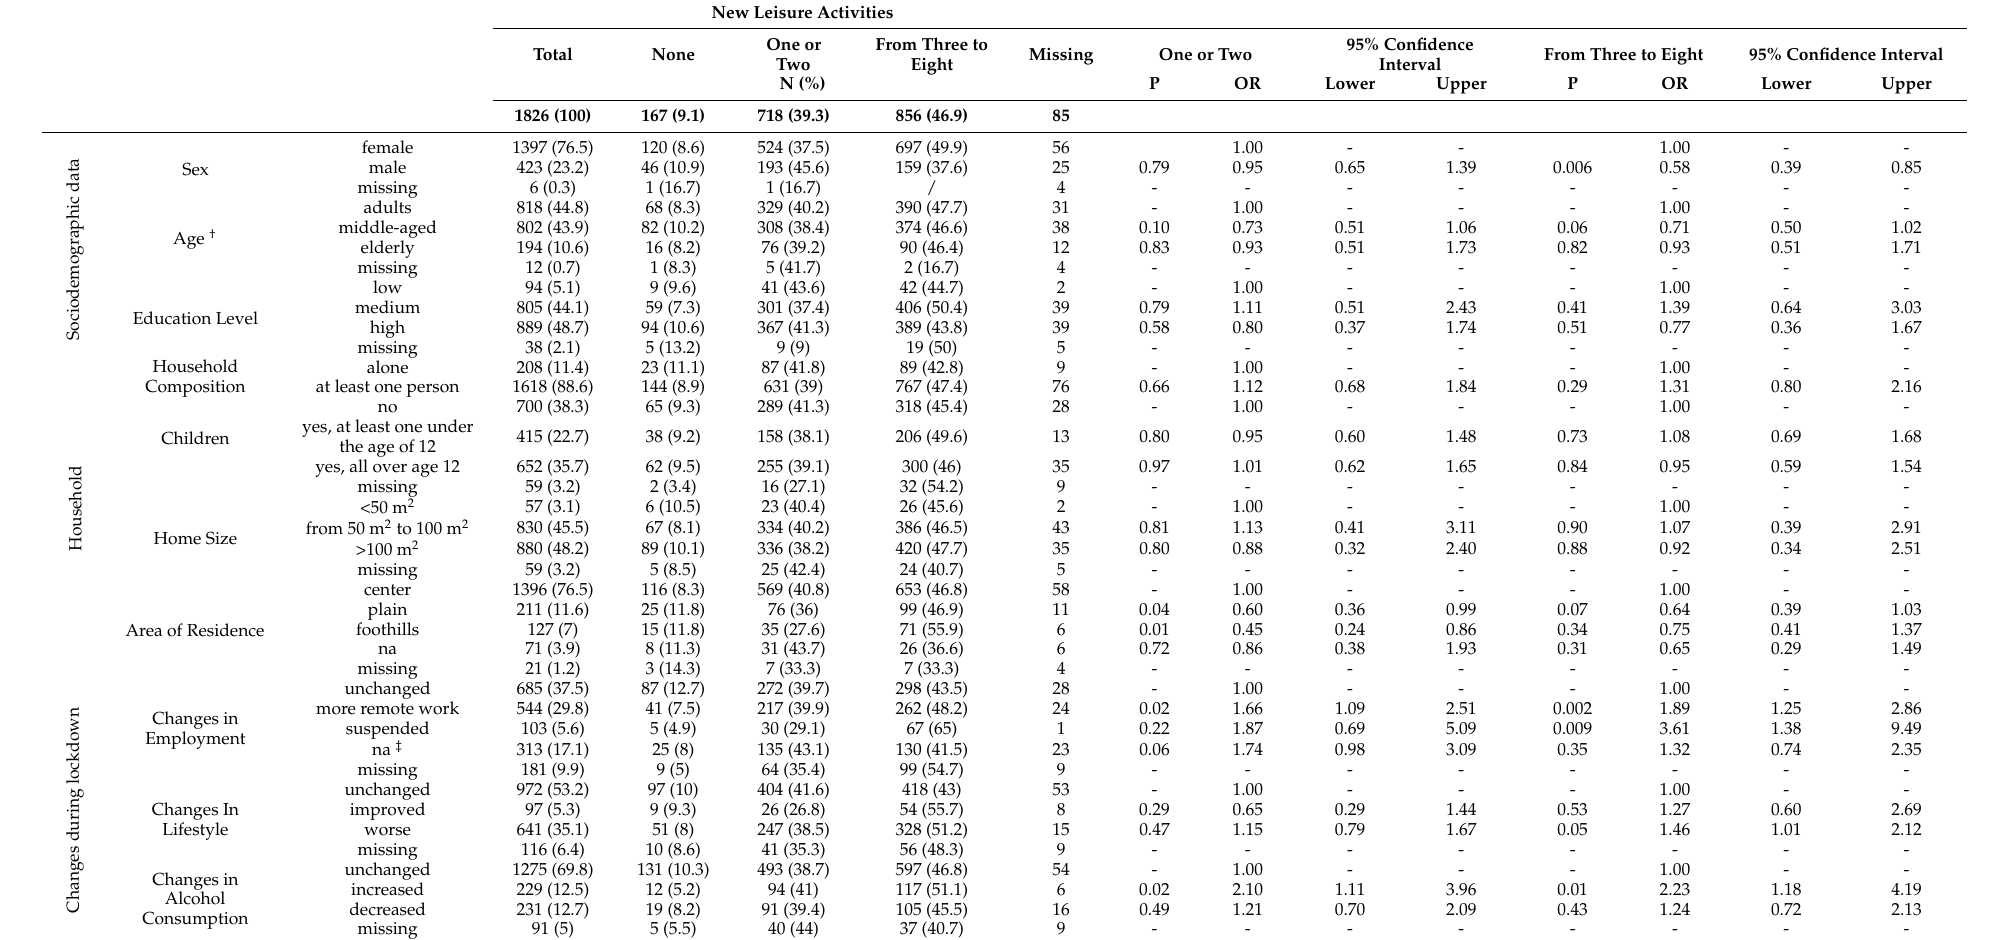
Table 1. Odds Ratios For Number Of New Leisure Activities (None, From One To Two, Or From Three To Eight) During COVID-19 Lockdown By Sociodemographic Data, Household, Changes During Lockdown, Technology, And Psychological